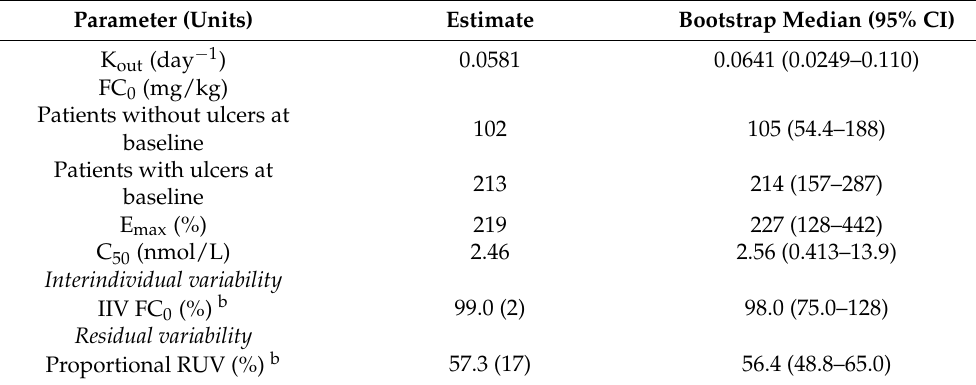
Table 3. Final pharmacodynamic model a parameter estimates. Parameter